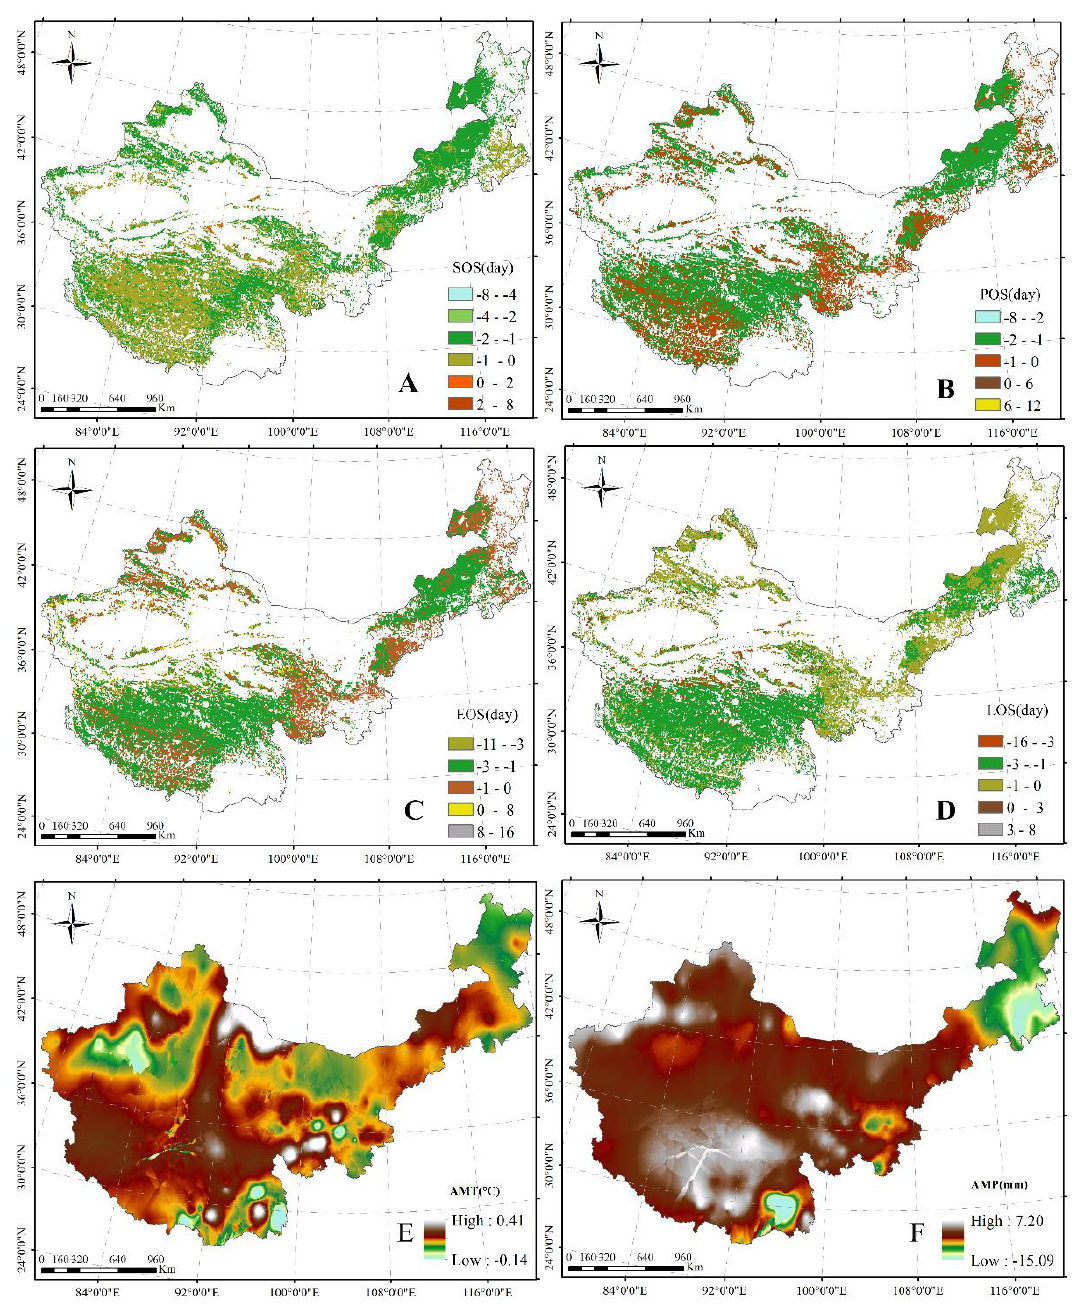
Figure 4. Spatial distribution of inter-annual change trends of grassland SOS ( A ); POS ( B ); EOS ( C ); LOS ( D ); AMT ( E ); and AMP ( F ) from 1985 to 2010 in northern China.